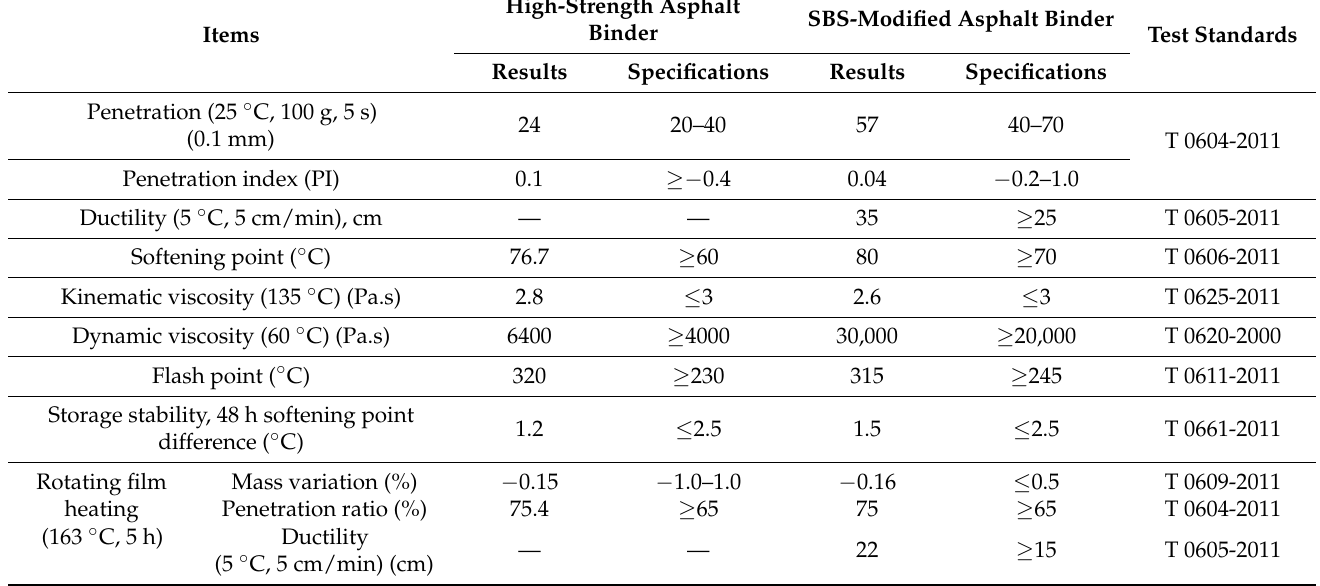
Table 1. Physical properties of high-strength and SBS-modified asphalt binders.